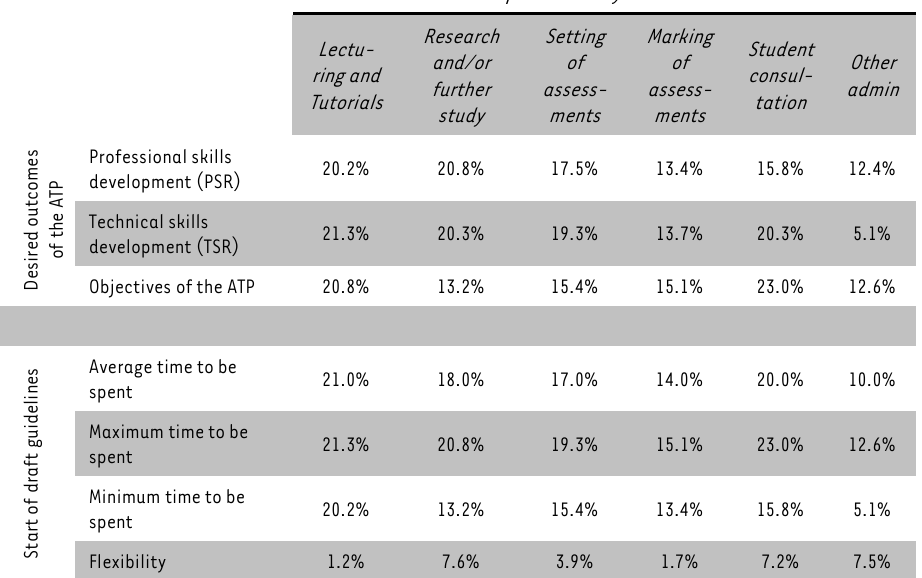
TABLE 7: Three-dimensional guideline measure